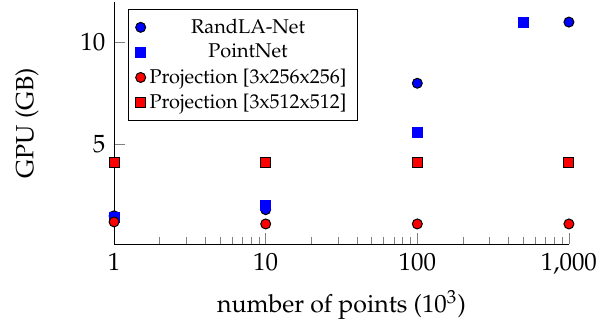
Figure 1. Memory consumption over number of points for point-based and projection-based